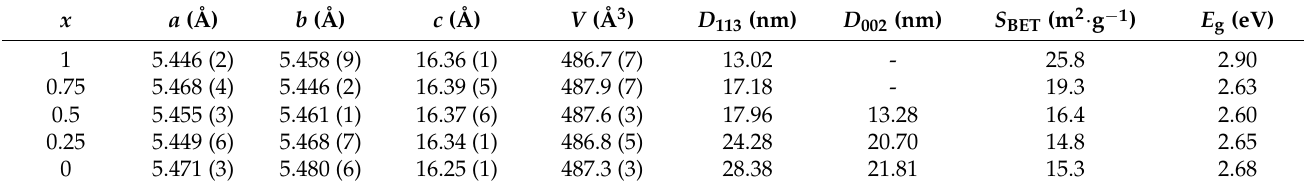
Table 2. Lattice parameters and physicochemical properties of Bi 2 W x Mo 1 − x O 6 layered perovskites.